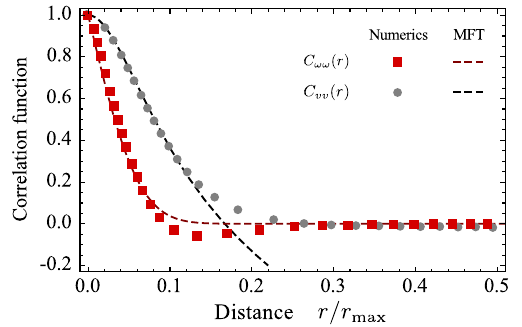
FIG. 8. Normalized vorticity (red dots) and velocity (gray dots) correlation functions obtained from a numerical integration of Eq. (1). The curves correspond to the mean-field theory (MFT) Eqs. (C3) and (C6), with R (cid:4) ¼ 0 . 034 r obtained from a fit of max the data. An extrapolation of R (cid:4) from the scale parameter a (cid:4) , as ffiffiffiffiffiffiffiffiffiffi p a (cid:4) = π defined in Eq. (3), can be obtained by setting R (cid:4) ¼ ; this gives R (cid:4) ¼ 0 . 054 r slightly larger than the value obtained from FIG. 9. (a) Number of defects and scale factor a (cid:4) versus activity max a fit of the correlation function. This slight discrepancy is for contractile (gray dots) and extensile (red dots) systems. presumably due to the inevitable systematic error in the calcu- (b) The scale factor a (cid:4) appearing in the vortex area distribution n ð a Þ versus the active length scale l lation of the vortex area from the Okubo-Weiss field, as well as the circular approximation of the vortex shape. (gray dots) and extensile (red dots)